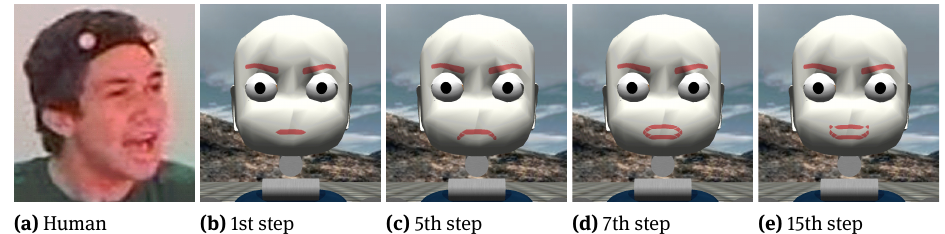
Figure 11: Example of the partner’s facial expression and reconstructed facial expressions by the mental simulation. (a) A screenshot of hu- man expression in this interaction. (b)-(e) Robot’s facial expressions reconstructed by the mental simulation mechanism from the partner’s hand movement and audio expressions at initial, fifth, seventh, and fifteenth step in the